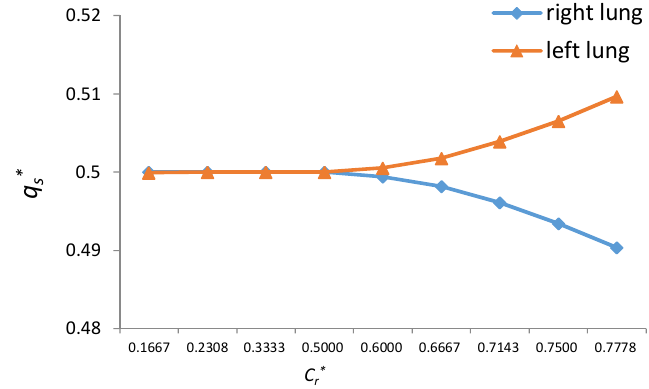
Figure 9. Influence of right lung dimensionless compliance on dimensionless peak suction flow.